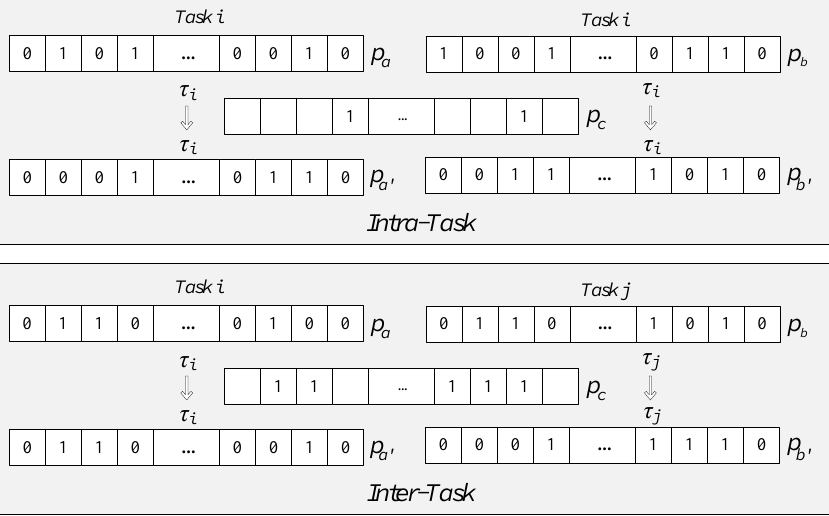
Figure 2. An example of the knowledge transfer.